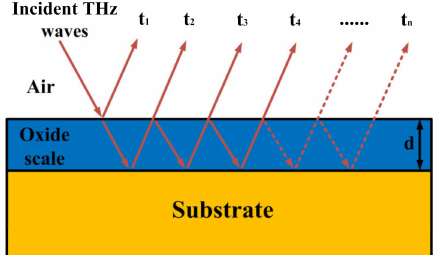
Figure 1. Schematic diagram of multiple reflections of terahertz waves between the oxide scale and the substrate.